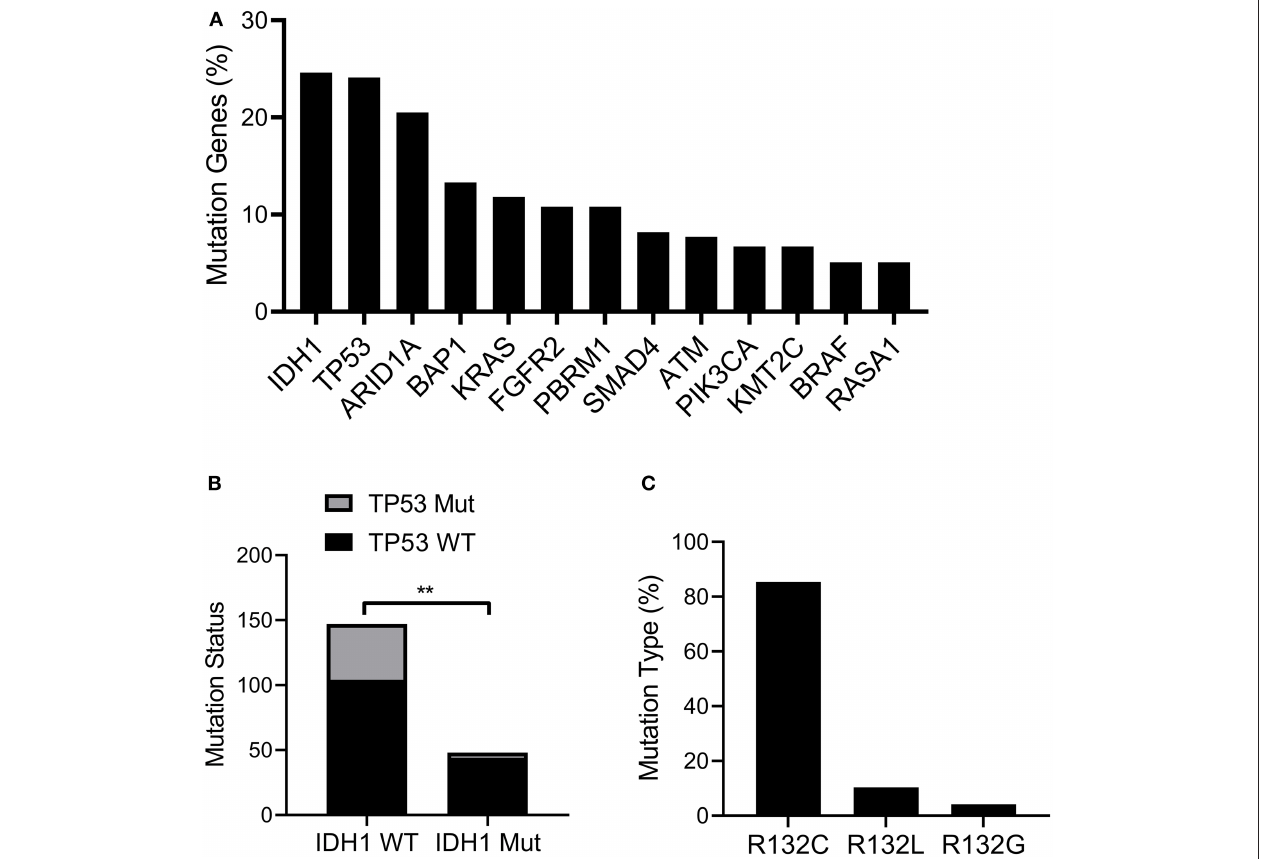
FIGURE 1 | IDH1 was mutated in cholangiocarcinoma. The TCGA cholangiocarcinoma dataset (MSK, Clin Cancer Res 2018) was downloaded and analyzed in cBioportal (www.cbioportal.org). (A) The frequency of mutated genes in Cholangiocarcinoma. (B) The proportion of TP53 mutated patients in IDH1 wildtype (WT) or mutated group. (C) The proportion of IDH1 with different mutation types. The data were represented as mean ± S.D. ** P < 0.01.